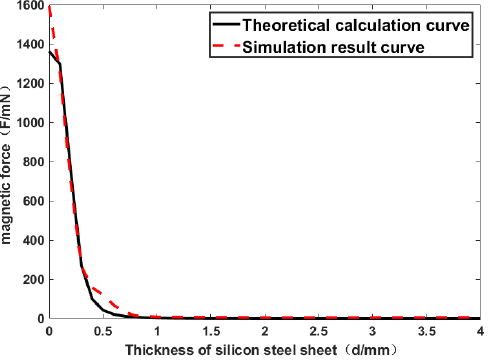
Figure 5. Comparison of theoretical and simulated curves of silicon steel thickness and magnetic